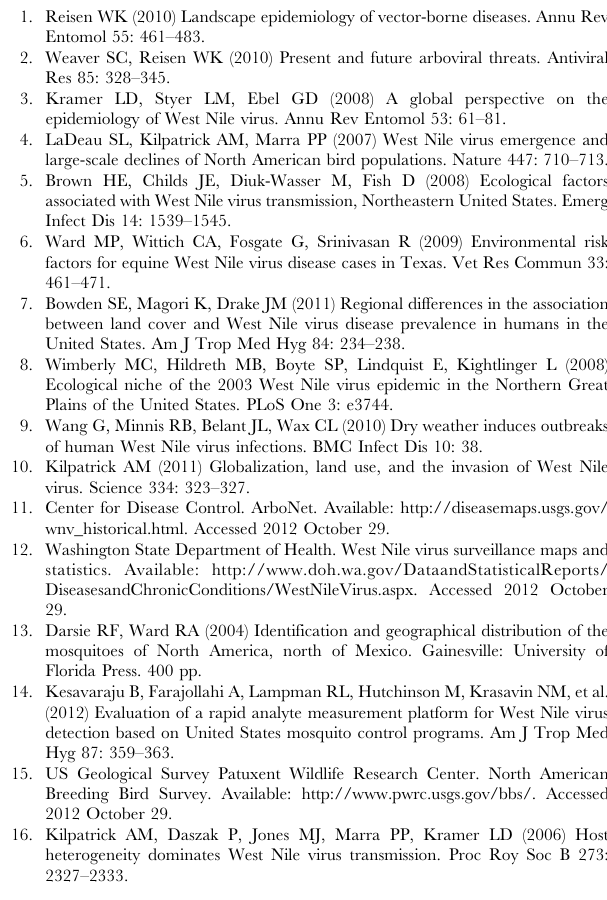
Figure S3 Akaike’s Information Criterion (AIC) from logistic regression models. Table S1 The classification of each habitat type from the Cropland Datalayer maps. Table S2 Results of non-parametric regression analy- ses. Table S3 Results of logistic regression